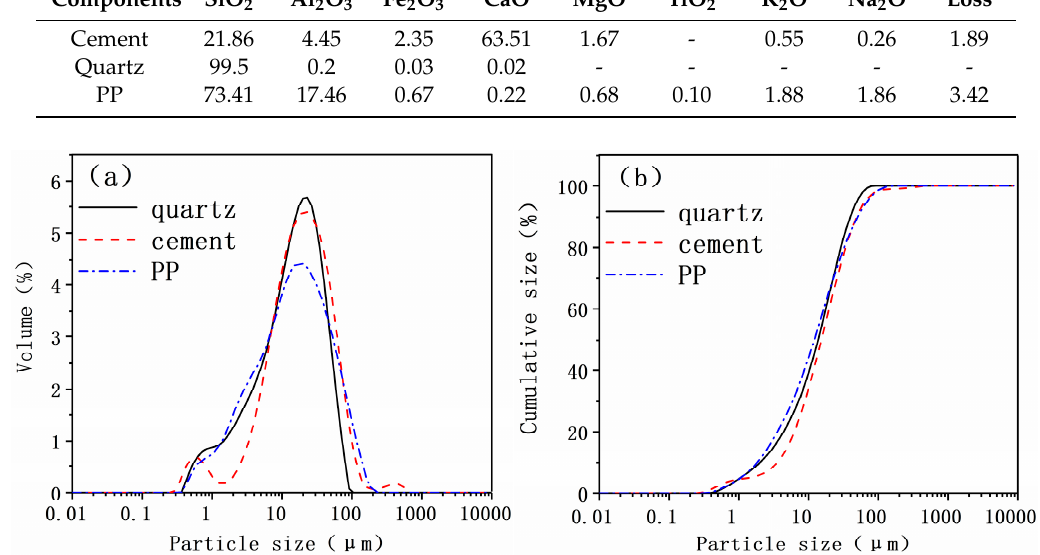
Figure 1. Volume distribution of particle size ( a ) and cumulative distribution of particle size ( b ) of quartz, cement, and ceramic polishing powder (PP).